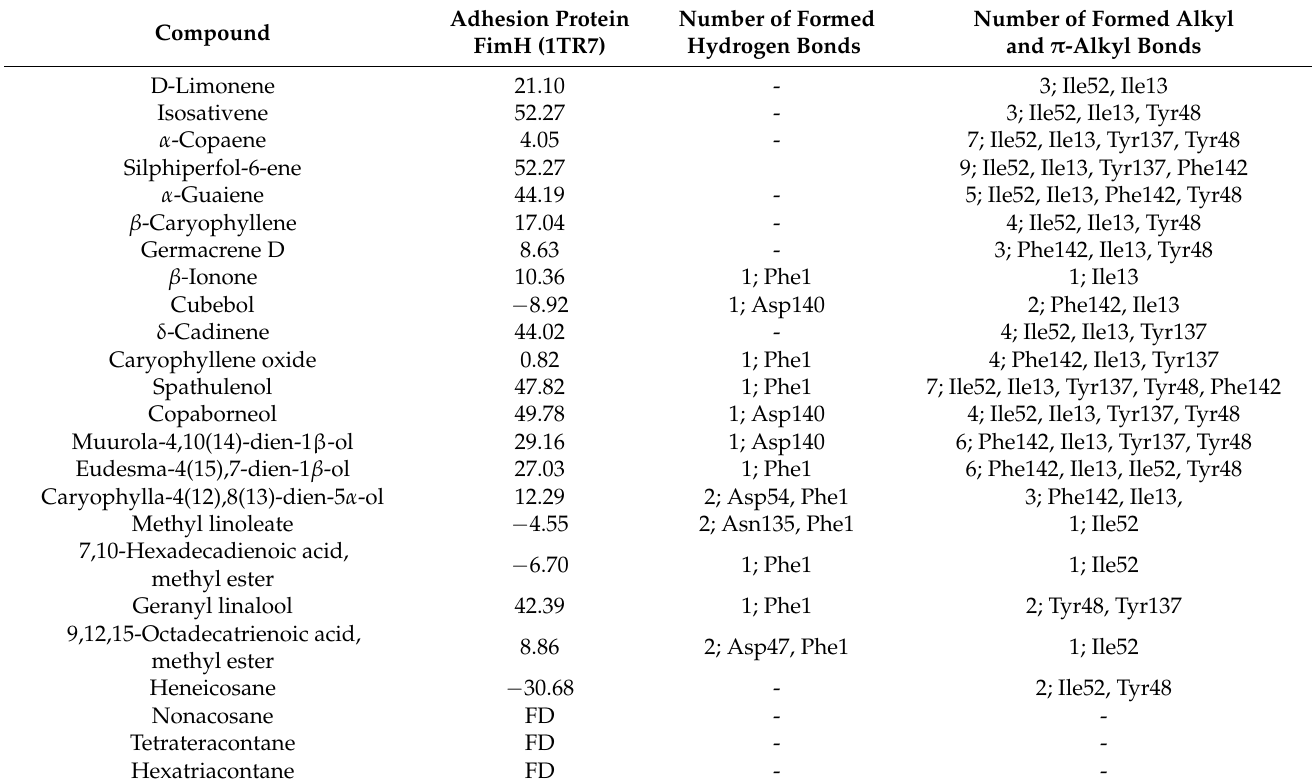
Table 3. Free binding energies (kcal/mol) of major compounds in the active site of E. coli adhesion protein FimH using in silico